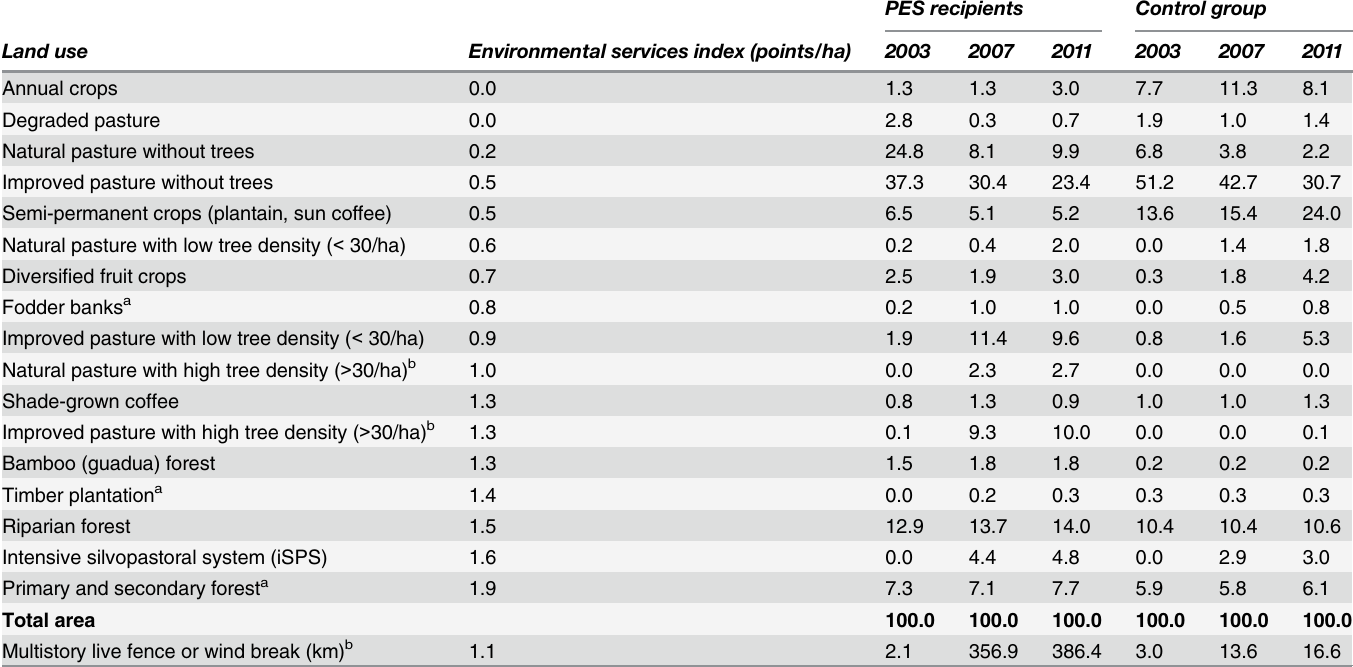
Table 1. Land use at the Silvopastoral Project site, Quindío, Colombia. (% of farm, unless otherwise